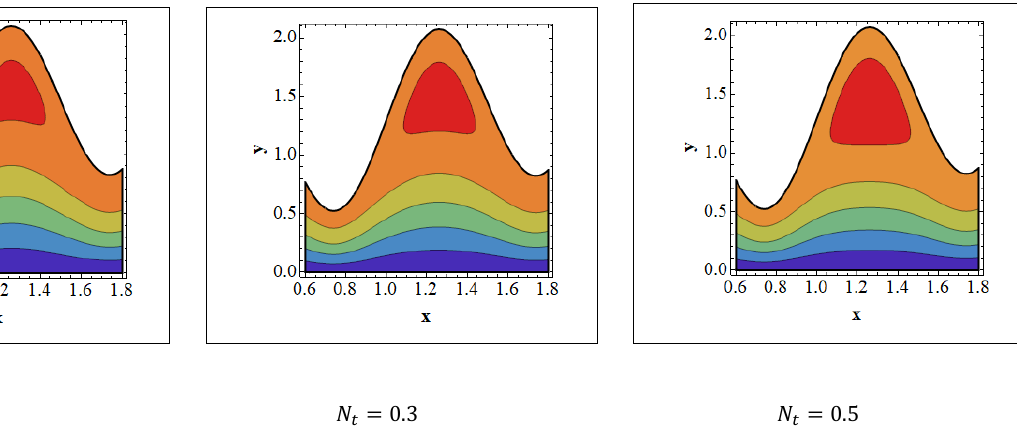
Figure 9. Streamlines for thermophoresis parameters. Values of other physical parameters are 𝑊𝑖 = 0.3, 𝑁 (cid:3021)(cid:3004) = 1.2, 𝑁 (cid:3029) = 0.4,𝑏 = 0.7, 𝑎 = 0.3, 𝑁 (cid:3004)(cid:3021) = 0.9, 𝑅𝑒 = 0.5,𝑆 (cid:2869) = 0.3, 𝑅 (cid:3040) = 0.5, 𝐺 (cid:3045)(cid:3030) = 1.4,𝐺 (cid:3045)(cid:3047) = 0.5, 𝐺 (cid:3045)(cid:3007) = 0.8, 𝛼 = 0.8,𝑄 = 3, 𝜂(cid:3556) = 1, 𝜇(cid:3556) = 1.